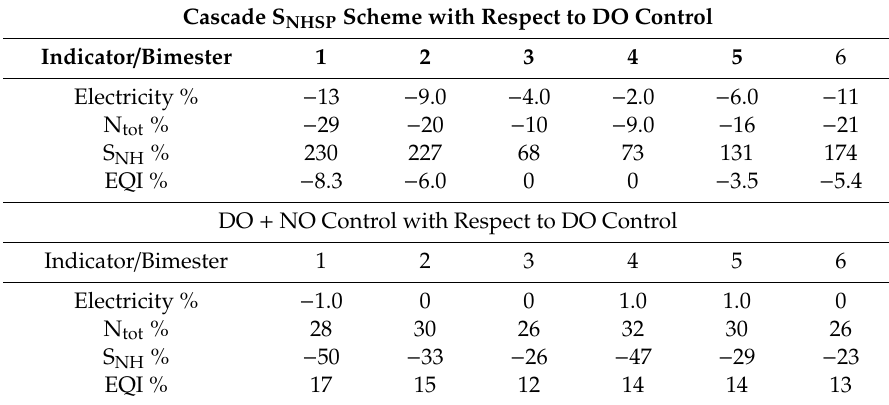
Table 6. Variation of bimonthly means of environmental indicators mainly a ff ected by the Cascade S NHSP and DO + NO control schemes with respect to default DO control scheme. Cascade S NHSP Scheme with Respect to DO Control Indicator /